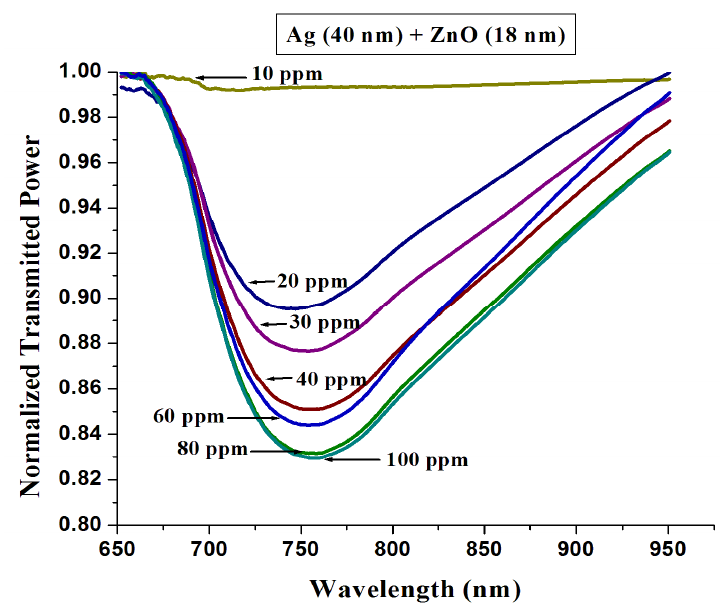
Figure 4. Normalized transmitted power spectra as a function of wavelength for different concentrations of chlorine gas.